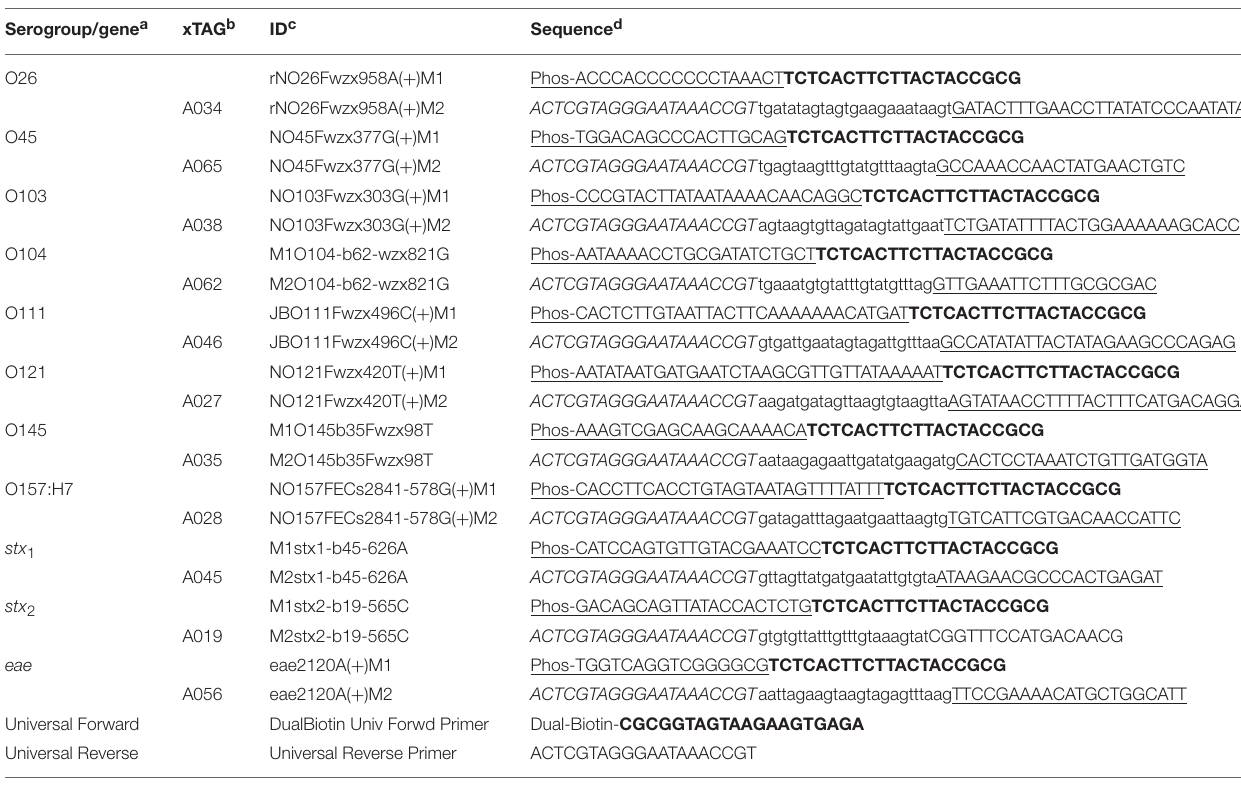
TABLE 1 | Sequences for MOLigo pairs with all portions